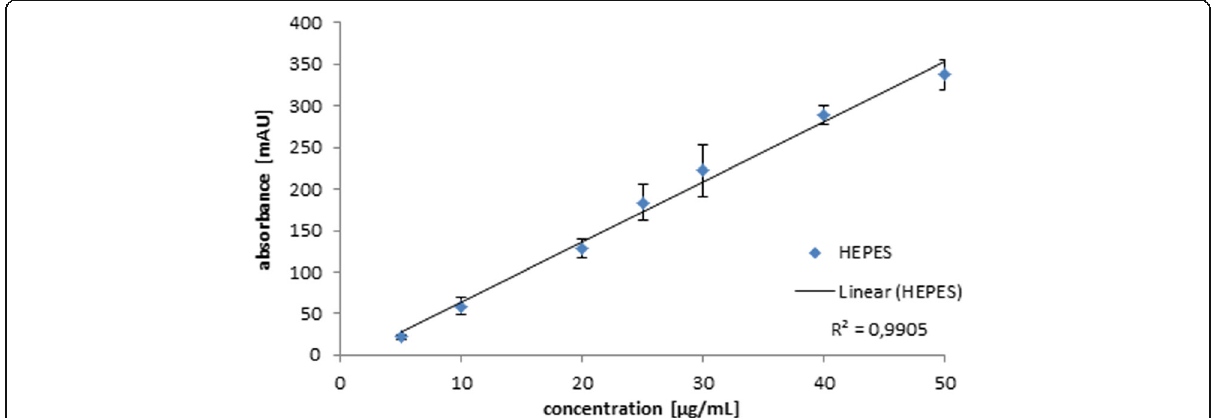
Fig. 5 Calibration curve of HEPES applying the HPLC assay according to Antunes et al. ( n = 3)